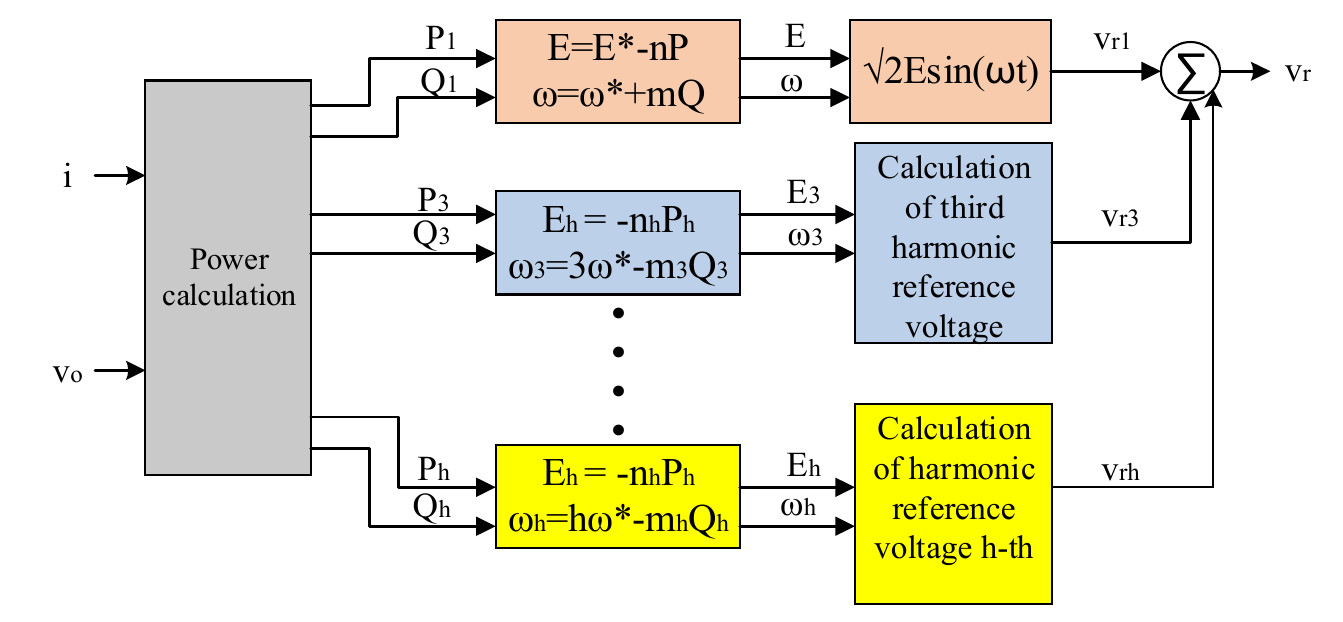
Figure 12. Droop controller with several harmonic droop controllers.